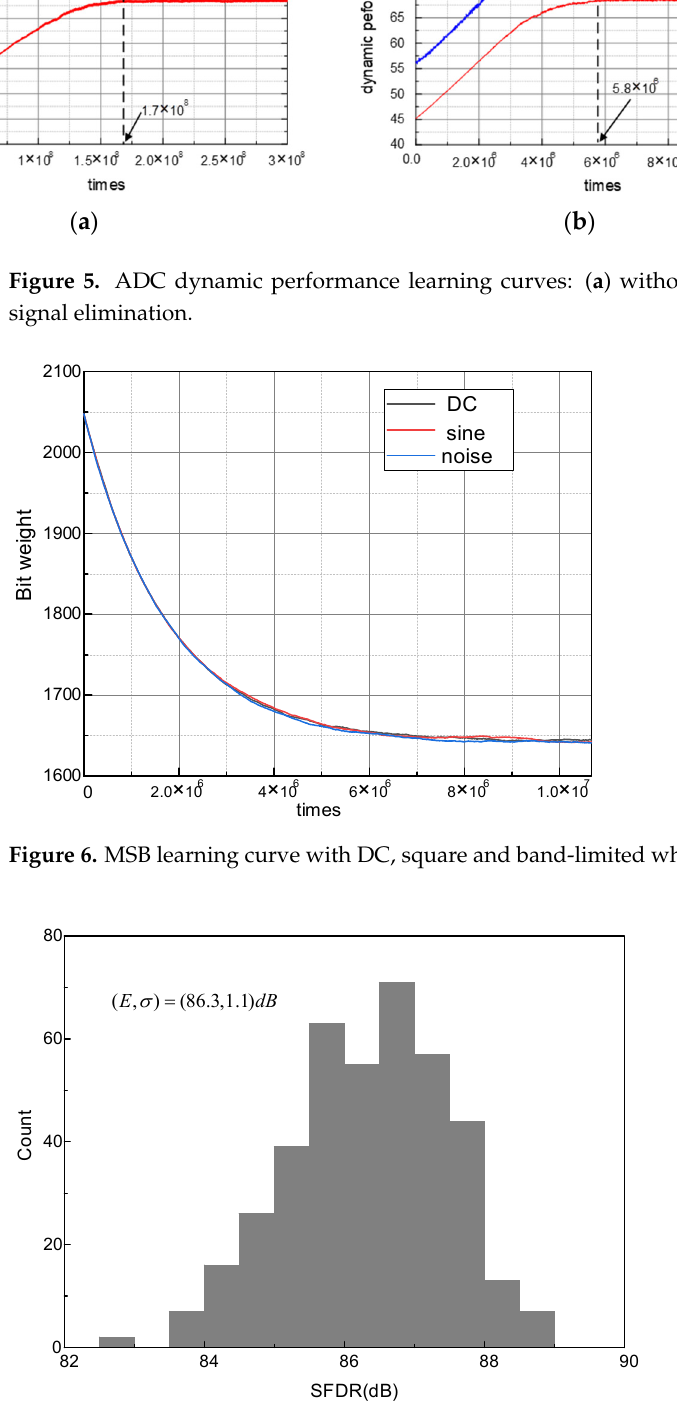
Figure 5. ADC dynamic performance learning curves: ( a ) without signal elimination; ( b ) with signal elimination.